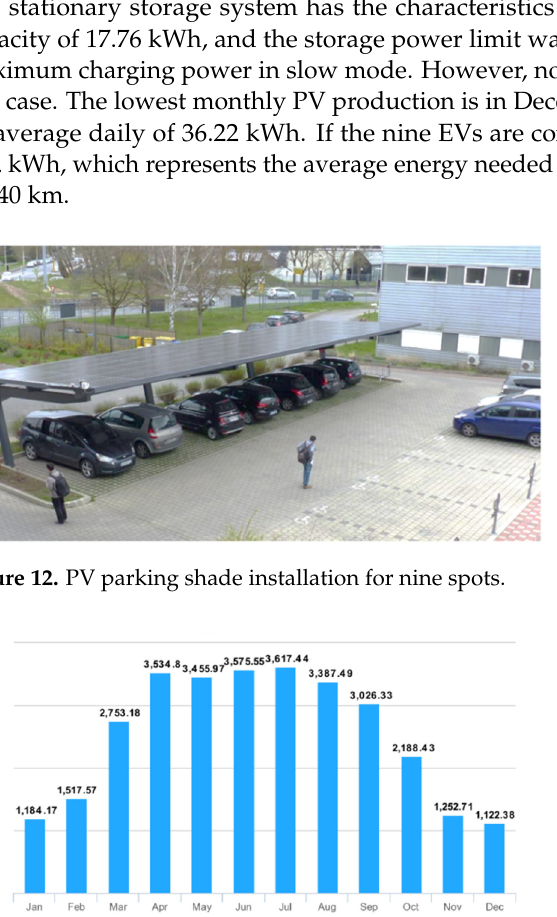
( b ) Figure 11. ( a ) Energy system distribution; ( b ) EV energy distribution for scenarios 1a and 1b.